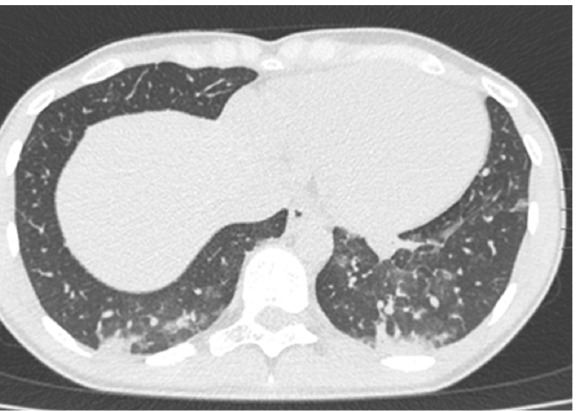
Figure 2. Baseline chest CT of a 27-year-old athlete. Confluent ground-glass opacities, pulmonary infiltrates.